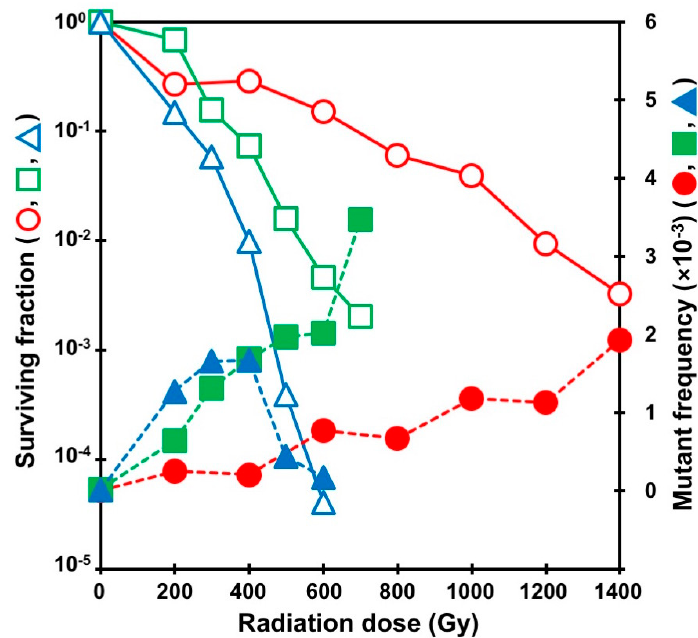
Figure 2. Relative biological e ff ectiveness (RBE) for lethality as a function of linear energy transfer (LET). Data are plotted on the linear (RBE) and logarithmic (LET) scales. Symbols: Red circles, Aspergillus oryzae ; blue squares, Escherichia coli ; green squares, Bacillus subtilis ; purple triangles, Deinococcus radiodurans . Data are modified from [24–27]. RBEs were recalculated based on the LET at the target surface. The highest values of RBE were obtained using 220 MeV 12 C 5 + ion beams for which the LET is 107 keV / µ m in all microorganisms tested except D. radiodurans , for which no RBE peak was observed because this bacterium was equally resistant to the ion beam and gamma rays.